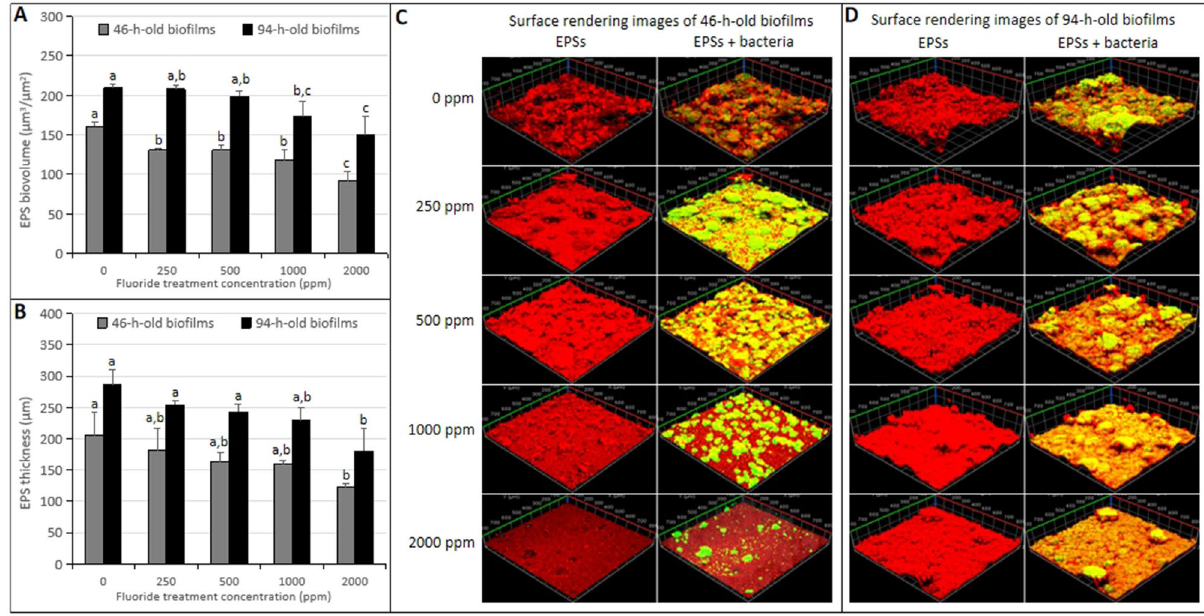
Figure 5. Change in confocal laser scanning microscopy of EPSs in the 46/94-h-old S. mutans UA159 biofilms treated with different concentrations of fluoride. ( A ) EPS biovolume. ( B ) EPS thickness. ( C )